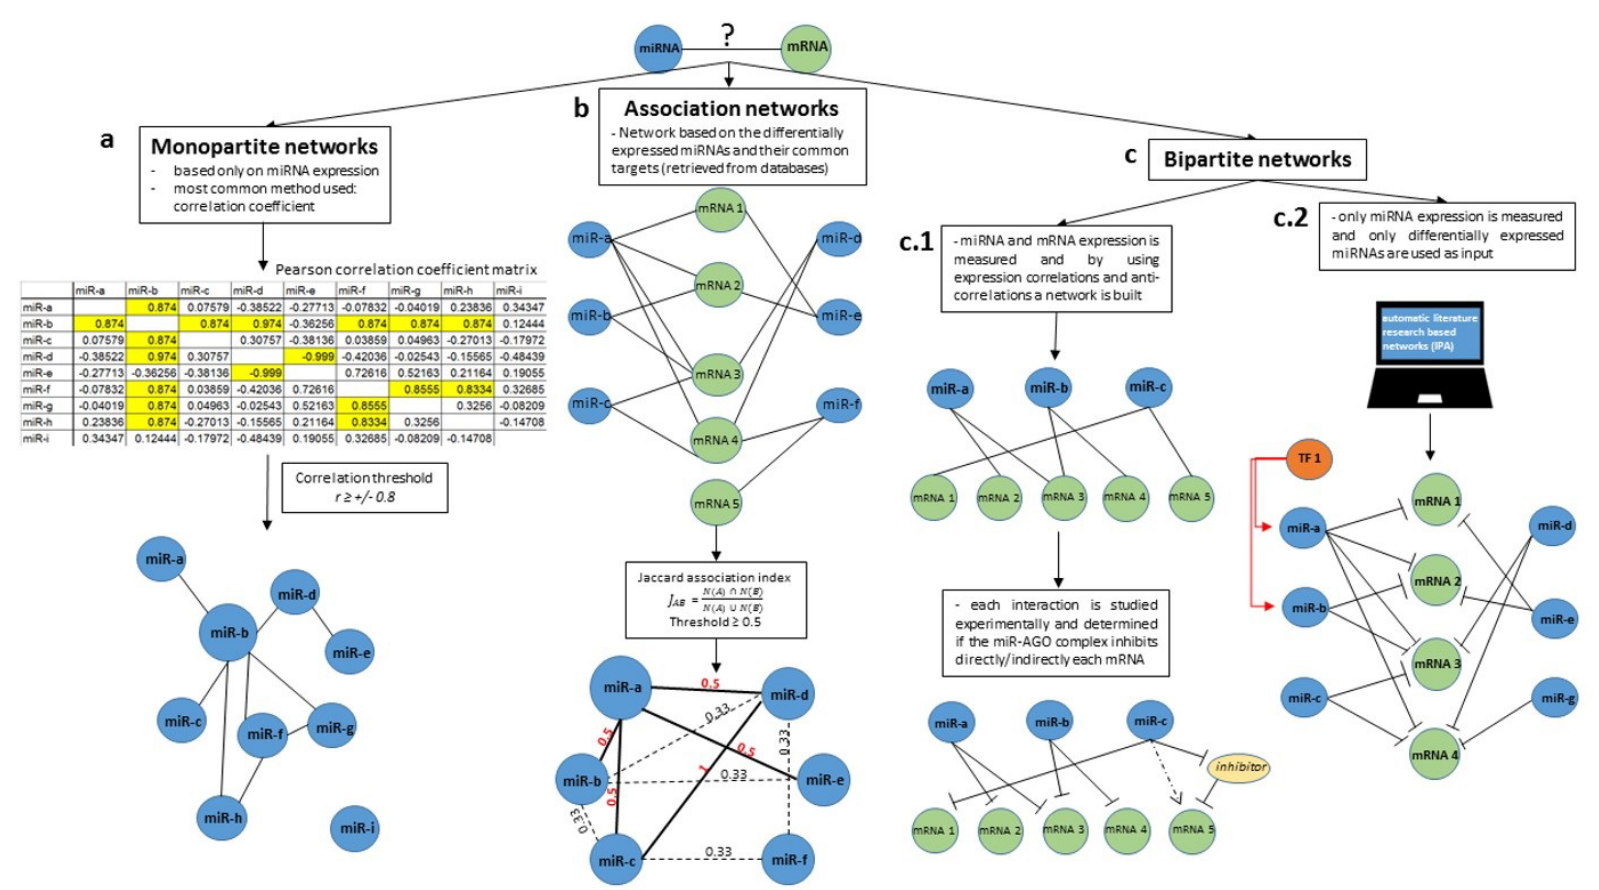
Figure 1. Building miRNA networks. The first questions that need to be answered before building a miRNA network are—what are the nodes? And what does an edge between two nodes mean? The different answers to these questions lead to the multiple types of miRNA networks that can be built. The network can be composed only of miRNA nodes. This type of networks containing only a single species of nodes are termed monopartite networks ( a ). The entire construct is based only on the expression level of miRNAs. The most common method employed to build monopartite graphs is the correlation coefficient. A correlation matrix is built using the expression level of several miRNAs in multiple patients of the same cohort. The entire method depends on choosing a correlation threshold. All the